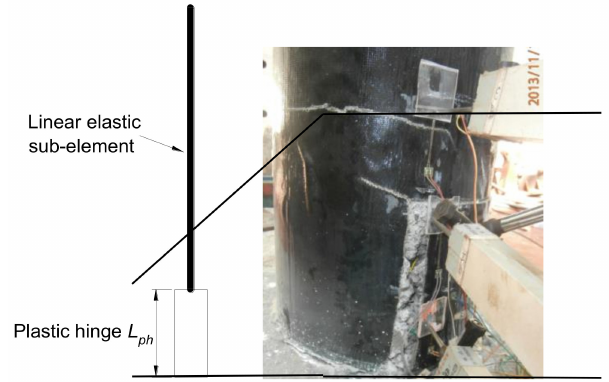
Figure 11. Plastic hinge’s